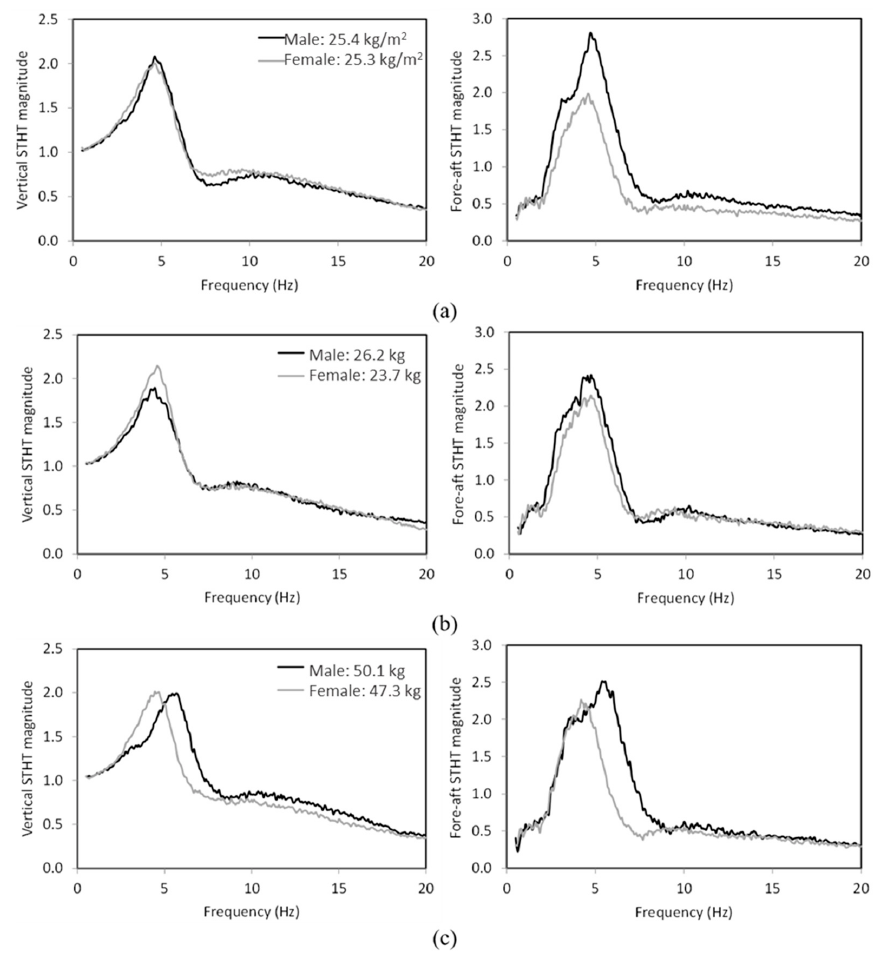
Figure 12. Effects of gender on mean STHT magnitudes considering comparable mass-related pa- rameters of males and females: ( a ) BMI; ( b ) fat body mass; and ( c ) lean body mass (NB support, 0.50 m/s 2 excitation).